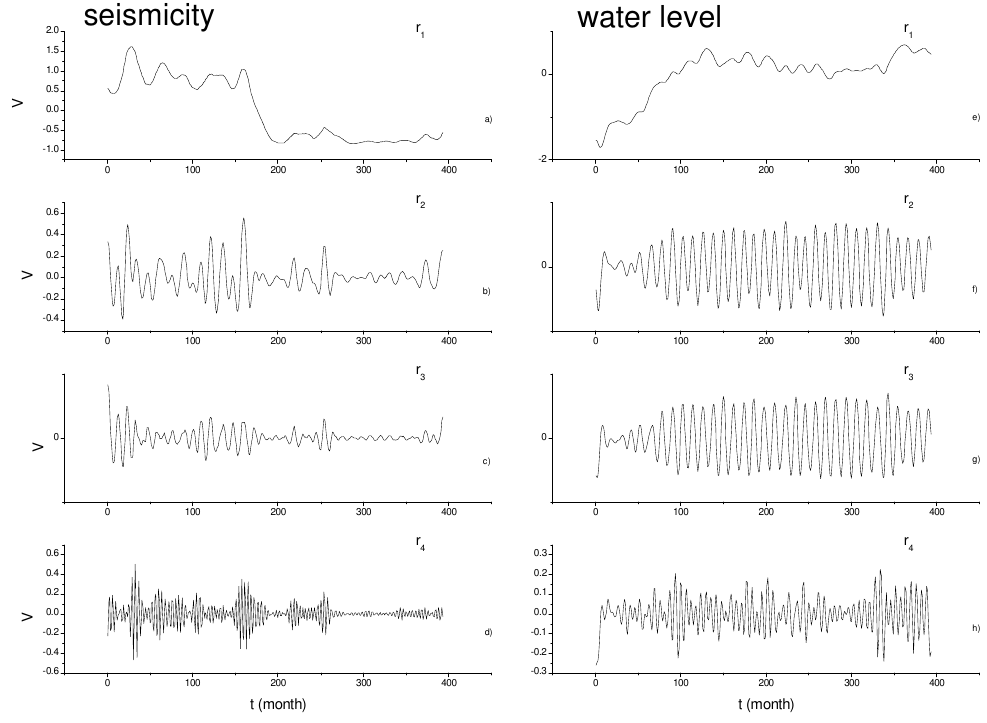
Fig. 6. The first four reconstructed components of both the monthly number of earthquakes (a–d) and the mean water level (e–h)